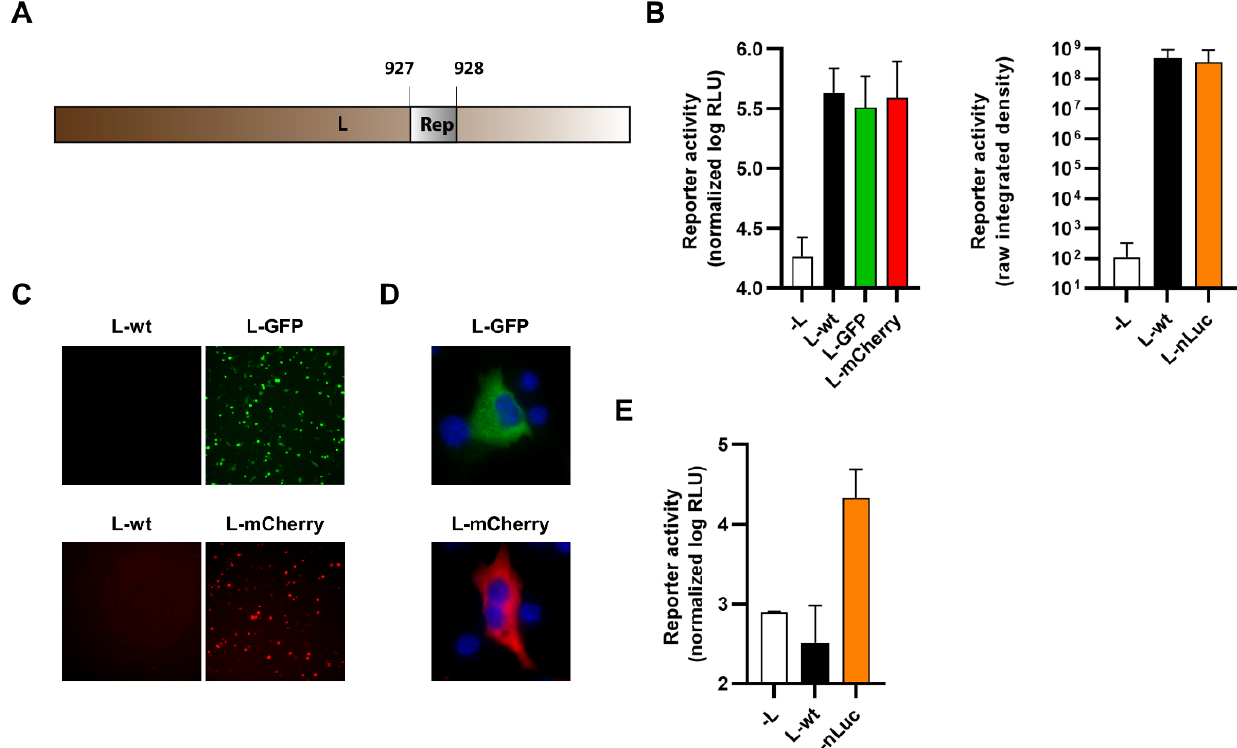
Figure 10. Internal fusion of TCRV L to reporter proteins. ( A ) Schematic. Reporter proteins were inserted within the TCRV L ORF between amino acids 927 and 928. ( B ) Minigenome activity. BSR- T7/5 cells were transfected with plasmid components for either a nLuc-based minigenome assay (left) or a GFP-based minigenome assay (right). For nLuc-based minigenome assays (left), cells were lysed after 48 h and both nLuc and FLuc activities were measured. Results are shown as the mean ± SD of the log of nLuc activity normalized to FLuc activity from four independent experiments. For GFP-based minigenome assays (right), pictures of each well were taken and used to measure the raw integrated density in the GFP channel. Results are shown as the mean ± SD of four independent experiments. ( C ) Reporter activity (GFP/mCherry). Pictures of cells transfected as in ( B ) were taken 48 h post-transfection at 10× magnification. Results are shown as representative images from one experiment out of two independent experiments. ( D ) Reporter localization. Pictures of cells transfected as in ( B ) were taken 24 h post-transfection at 63× magnification after fixation and DAPI staining. Results are shown as representative images from one experiment out of two independent experiments. ( E ) Reporter activity (nLuc). Cells transfected as in ( B ) were lysed 48 h post-transfection, and nLuc activity in lysates was measured. Results are shown as mean ± SD of four independent experiments.